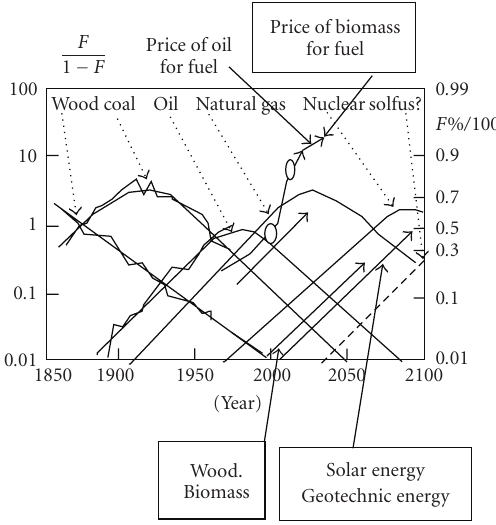
Figure 1: Globally most used energy sources. During 2001–2005 the oil price doubled and also in 2007-2008. Modified from [1].